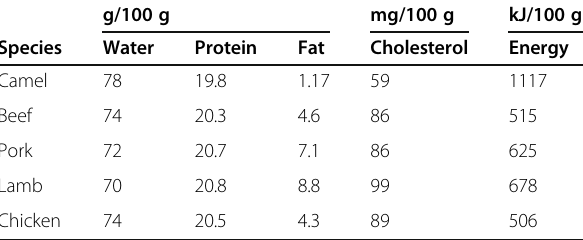
Table 2 Meat compounds of different species (average values) g/100 g